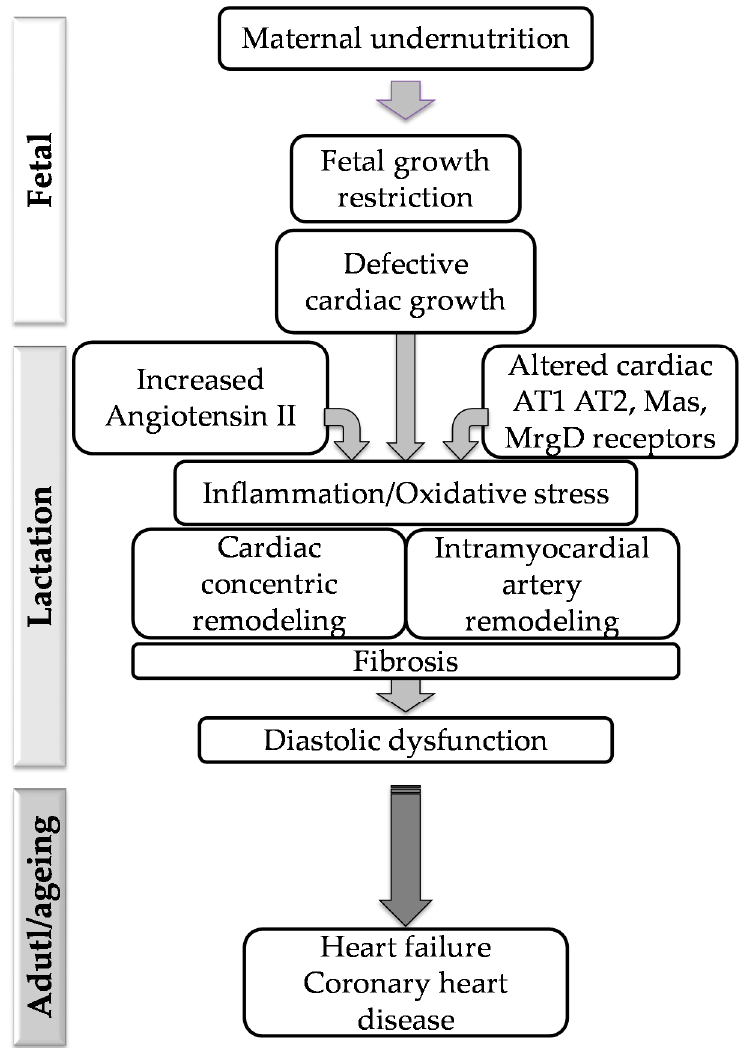
Figure 7. Schematic diagram depicting the relationship between fetal undernutrition, alterations in Ang II and RAS cardiac receptors during lactation and development of cardiac structural and functional alterations, which may contribute to long-term heart disease.